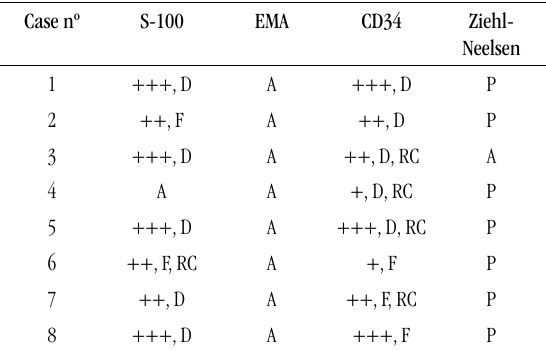
tABLE 2 – Immunohistochemical and histochemical profile of oral neurofibromas diagnosed between 1994 and 2010 in the DPML, Universidade Federal do Ceará, Brazil Case nº S-100 EMA CD34 Ziehl-